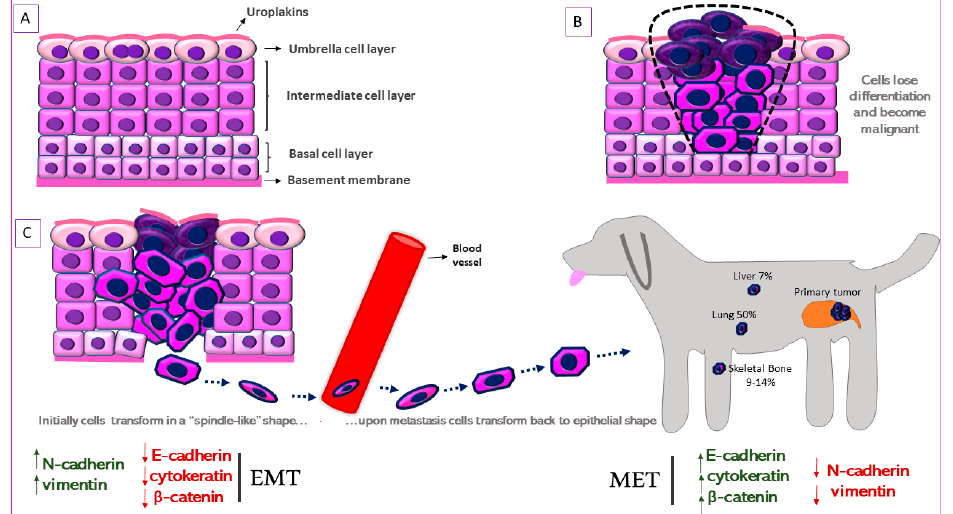
Figure 2. Schematic representation of Epithelial-to-Mesenchymal Transition (EMT) in canine MIUC. ( A ). Structure of normal urothelium. ( B ). Urothelial tumor outlined with the black dashed line. ( C ). EMT process in which the immotile urothelial cells upregulate mesenchymal (N-cadherin, vimentin) and downregulate epithelial (e-cadherin, cytokeratin) markers, acquire a “spindle-like” shape, become motile and infiltrate surrounding tissues and blood vessels. When they reach the metastatic site, the process is reversed (Mesenchymal-to-Epithelial Transition, MET) accompanied by the upregulation of mesenchymal and downregulation of epithelial markers. Some of the most common metastatic sites are depicted.